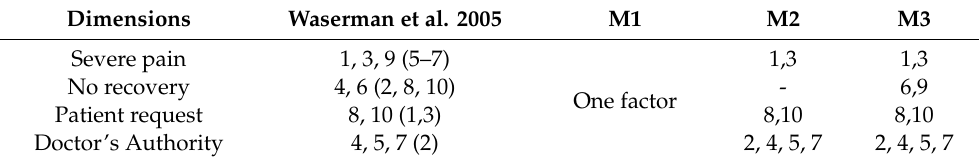
Table 4. Comparative analysis of dimensions’ number between this model and Waserman et